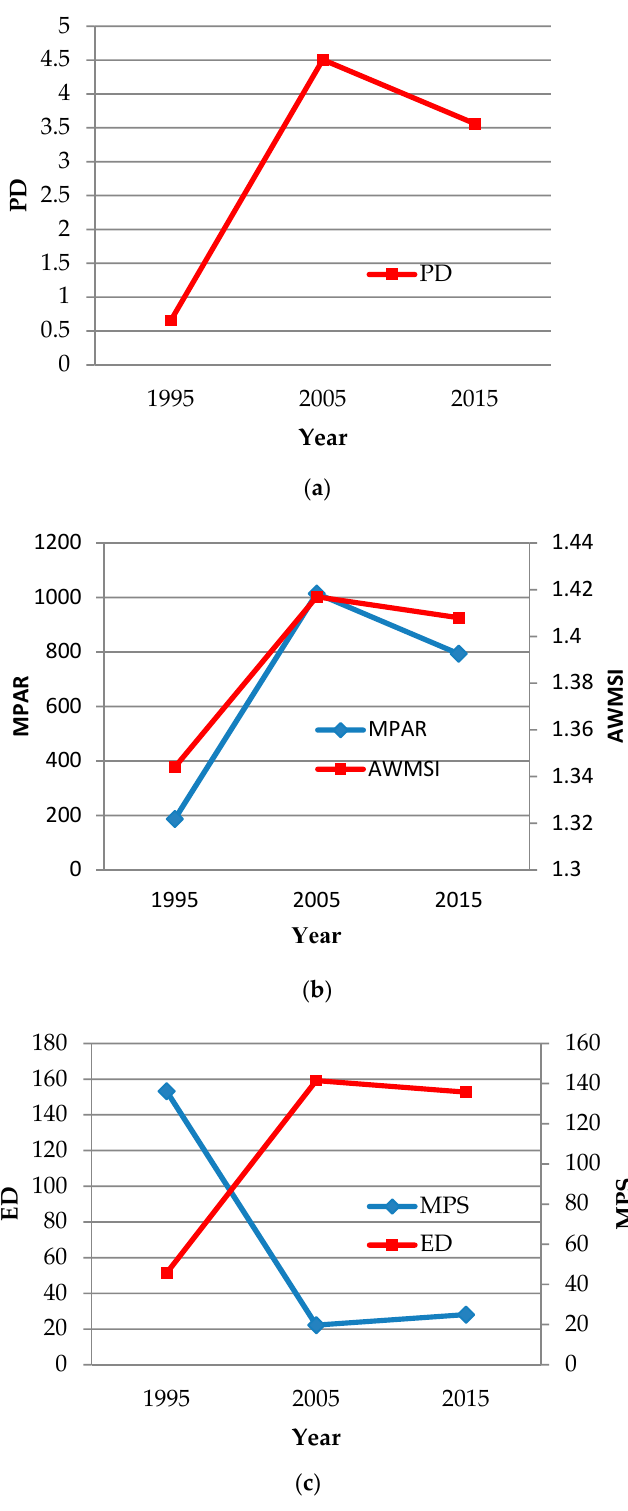
Figure 12. Changes of different landscape metrics (1995–2015). ( a ) Changes of PD; ( b ) Changes of MPAR and AWMSI; ( c ) Changes of ED and MPS.